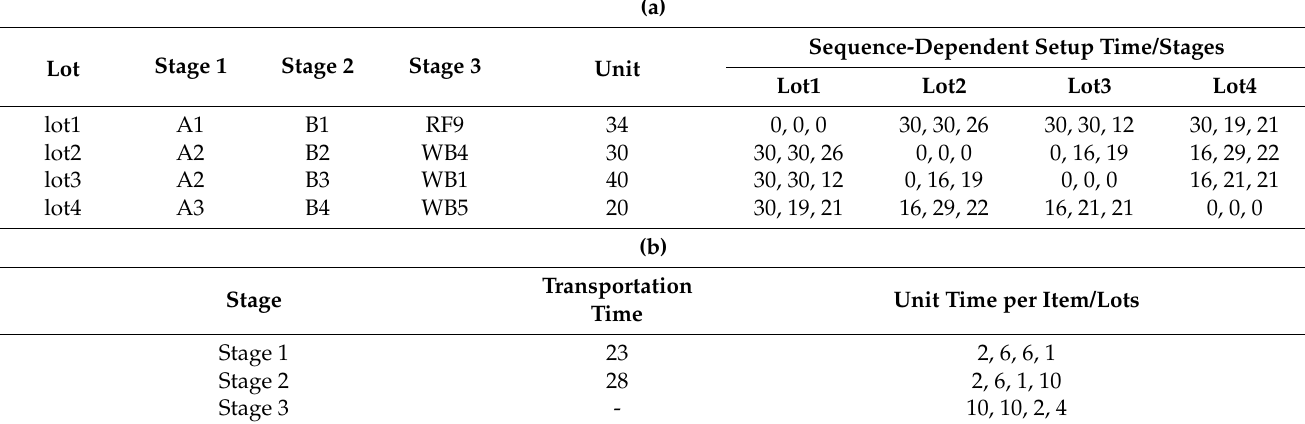
Table 5. The case data. ( a ). Production data for the illustrative example. ( b ). Production data for the illustrative